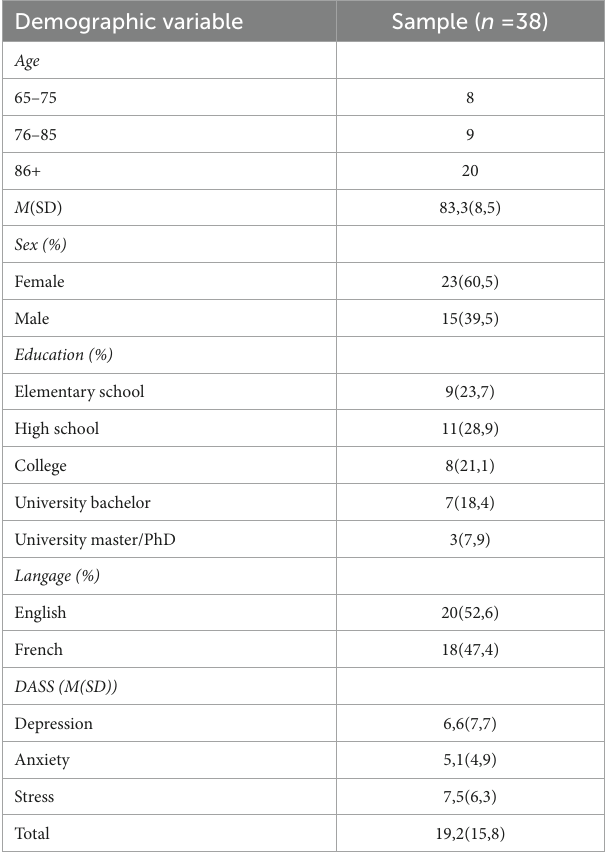
TABLE 1 Demographic